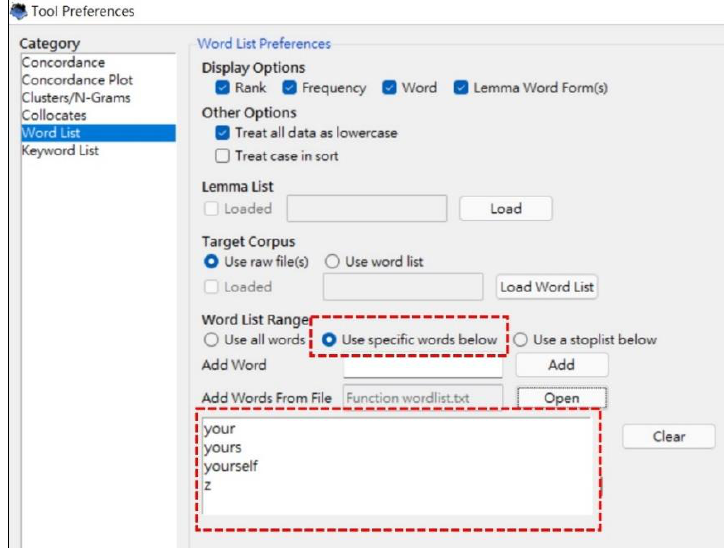
Figure 5. Set the function word list as “specific words”.